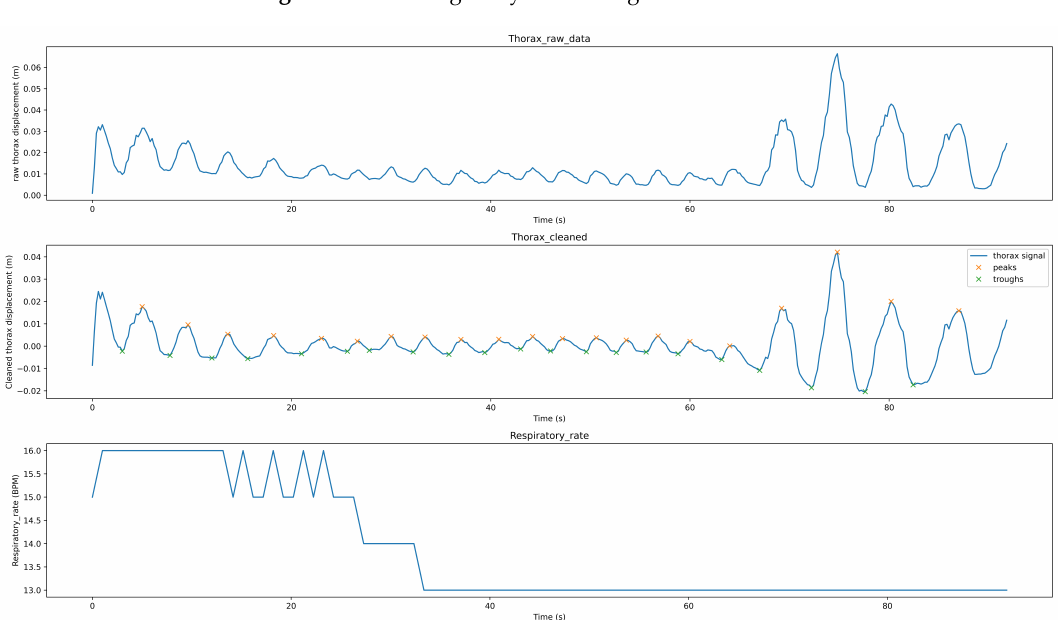
Figure 11. Breathing analysis for a beginner